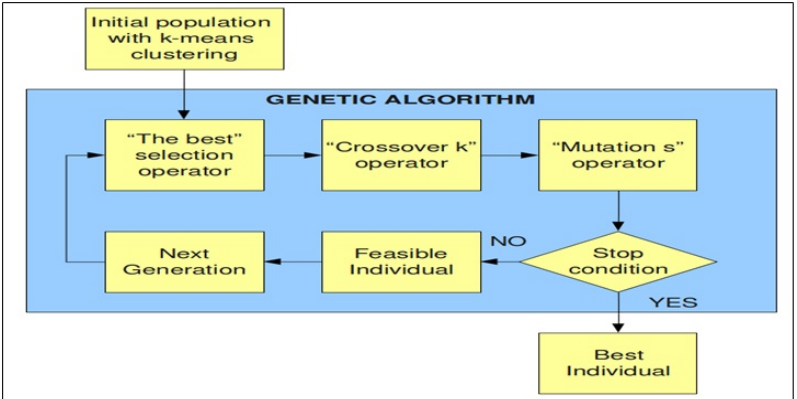
Figure 1. General scheme of the genetic algorithm vehicle routing problem with time windows (GA-VRPTW) algorithm [1].